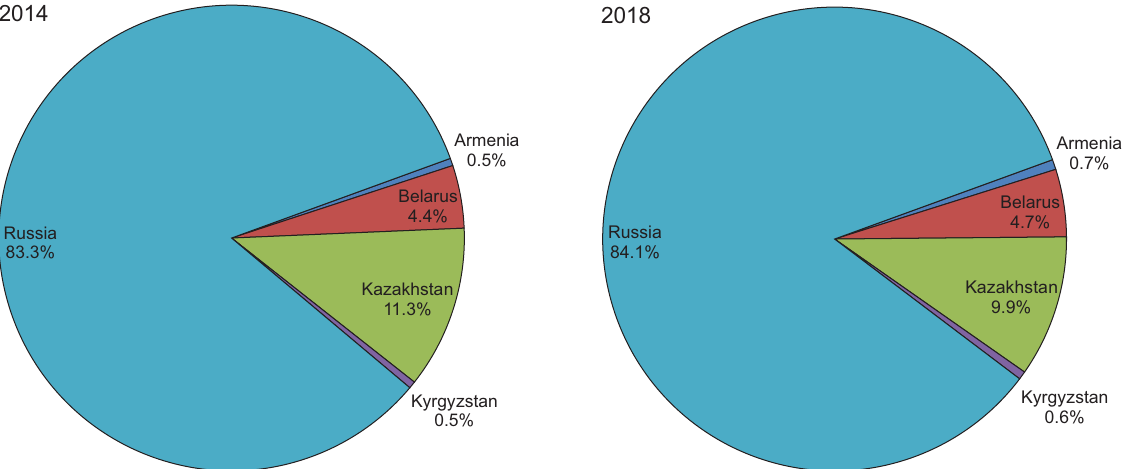
Fig. 4. Share of the EAEU member states in foreign merchandise trade (in turnover). Source: own study based on the Eurasian Economic commission (n.d.).